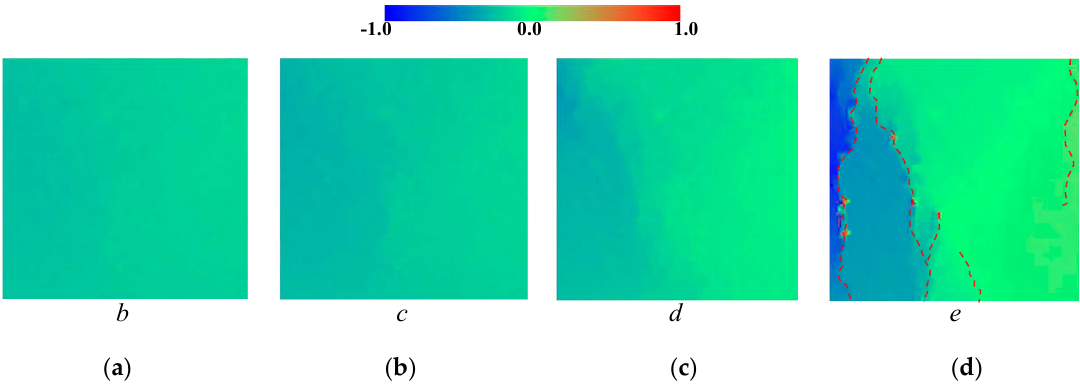
Figure 12. Lateral displacement distribution contour maps from DIC measurements (unit: mm) ( a ) loading stage b ; ( b ) loading stage c ; ( c ) loading stage d ; ( d ) loading stage e .